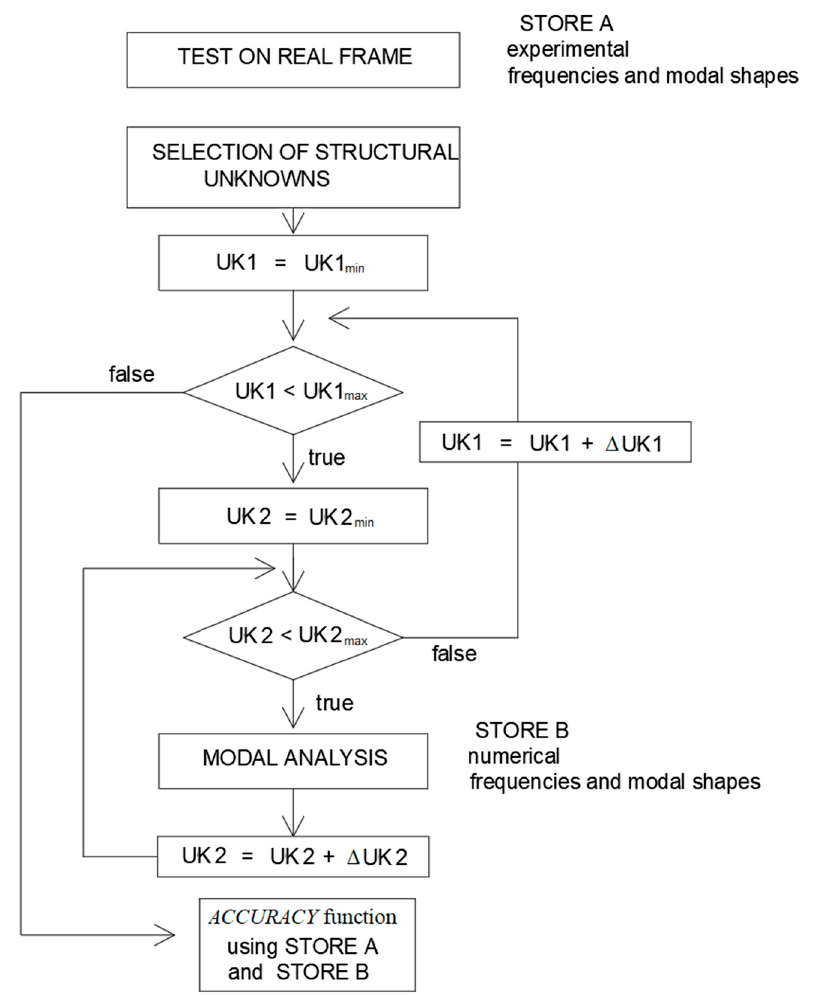
Figure 3. Flow chart of the proposed procedure.